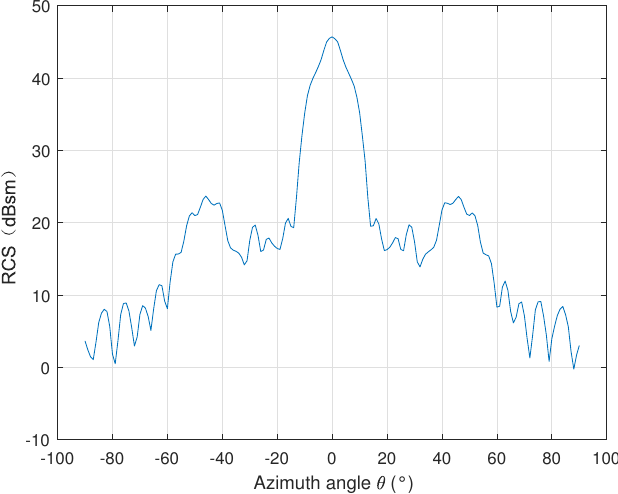
Figure 3. The RCS pattern of the parabolic antenna. The peak RCS value of the parabolic antenna is 45.71 dBsm, and the 3 dB-beamwidth is 8 ◦ . Compared with the TCR, the beamwidth of the parabolic antenna is narrow.